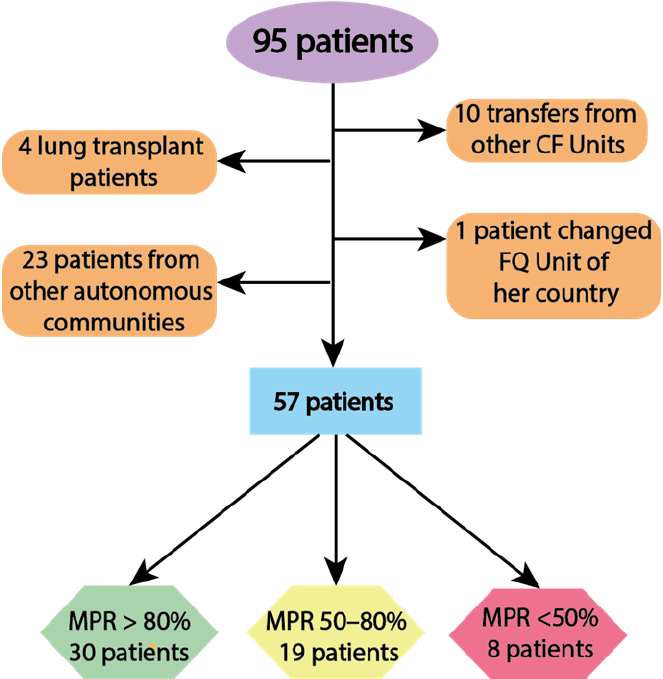
Figure 1. Flowchart of participants, classifying patients according to their Medication Possession Ratio (MPR) percentage. The patients assessed for this study were stratified into three subgroups (MPR > 80%, MPR 50 – 80%, MPR < 50%) according to their MPR% for all treatments followed throughout the study. The mean age of all patients evaluated was 33.9 ± 9.4 years, 59.6% female, 35.1% ho- mozygous F508del, 80.7% with pancreatic insufficiency, 42.1% with diabetes, 24.6% with allergic bronchopulmonary aspergillosis and 15.8% with massive hemoptysis. Lung func- tion at baseline, as assessed by the mean percentage of Forced Expiratory Volume in 1 s (FEV 1 %) and the mean percentage of Forced Vital Capacity (FVC%), was 71.0 ± 20.3 and 82.7 ± 15.6, respectively. Chronic bronchial infection by Pseudomonas aeruginosa was pre- sented in 22 patients (38.6%), and 16 (28.1%) and 10 (17.5%) for methicillin-sensitive Staph- ylococcus aureus (MSSA) and methicillin-resistant Staphylococcus aureus (MRSA), respec- tively (Table 1).